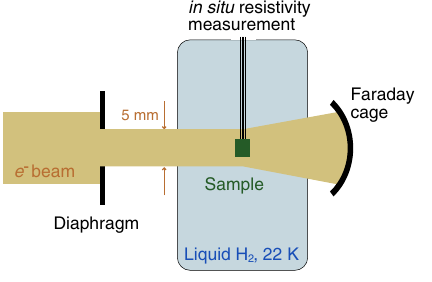
FIG. 4. A sketch of the experimental setup for electron irradiation. The yellow area indicates the range in which the electron beam is swept, rather than representing the beam cross section.